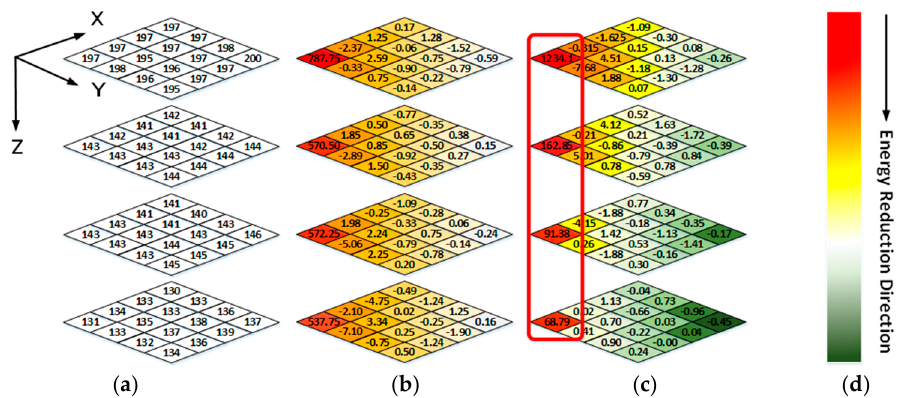
Figure 5. ( a ) Raw data of one image block ( b ) The frequency spectrum data of 2-D DCT ( c ) The frequency spectrum data of 3-D DCT ( d ) Color bar of energy intensity representation.